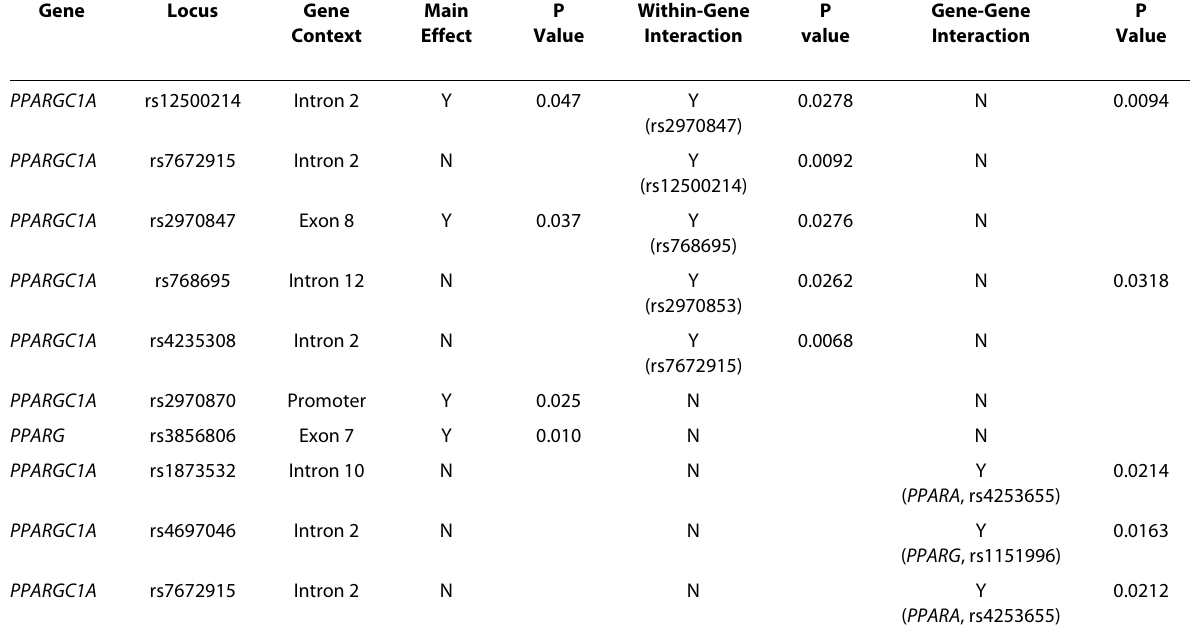
Table 6: Significant Gene-Gene interactions in three PPAR -complex genes with latent LVDD endophenotype (E61).